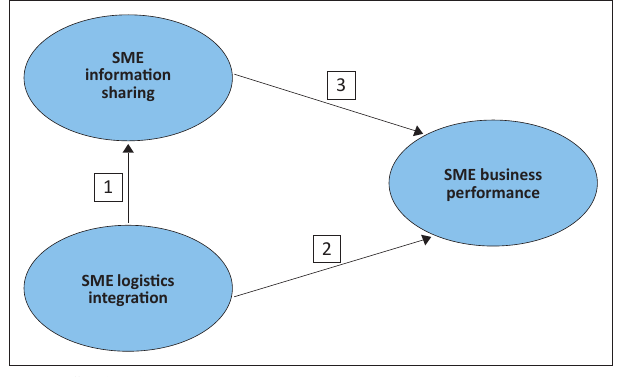
FIGURE 1: Conceptual research